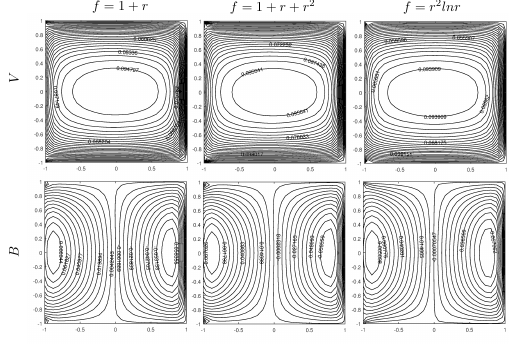
Figure 2. Velocity and induced magnetic field from direct solution, π , α = 0 . 2 , c = 0 . 3 , M = β = 2